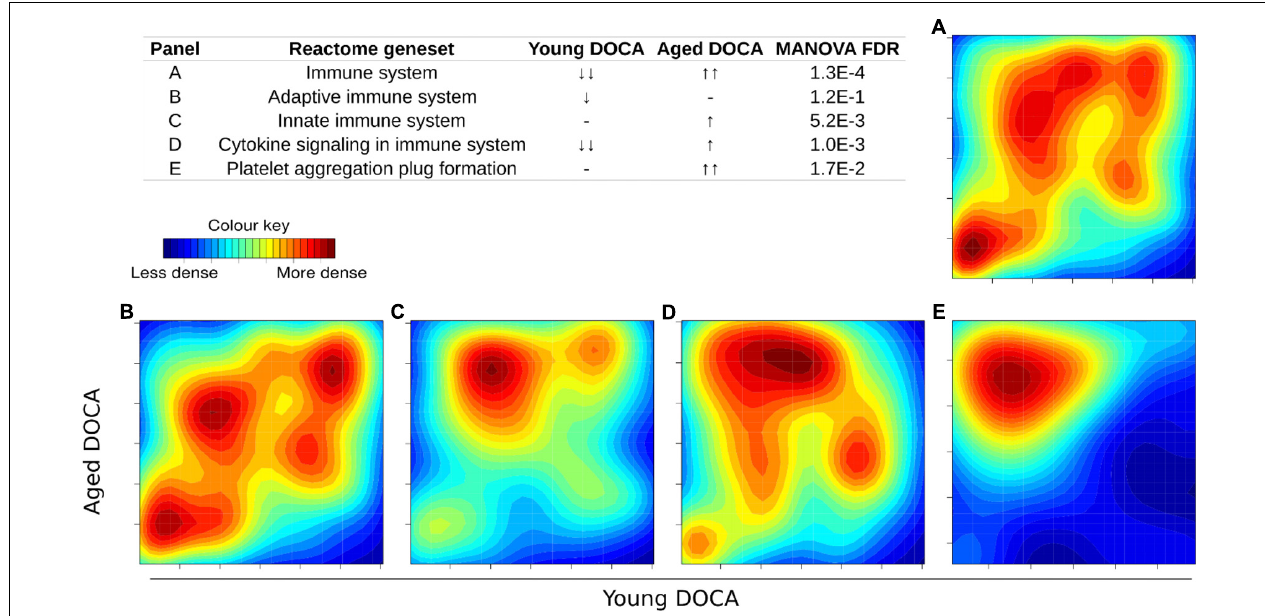
FIGURE 8 | Two-dimensional pathway analysis showing the activation of the immune system and inflammation in DOCA mice. (A) The immune system and (B) adaptive immune system were up-regulated in both ages. (C) The innate immune system, (D) cytokine, and (E) platelet signaling, among other inflammatory markers, were specifically up-regulated in aging DOCA mice only. Sample size: n = 6 young DOCA vs. n = 4 aging DOCA